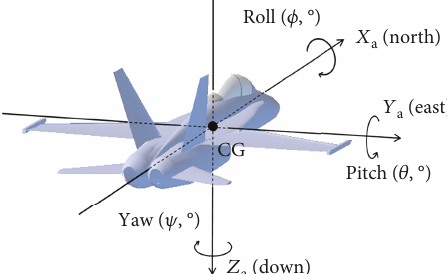
Figure 12: Aircraft reference system.